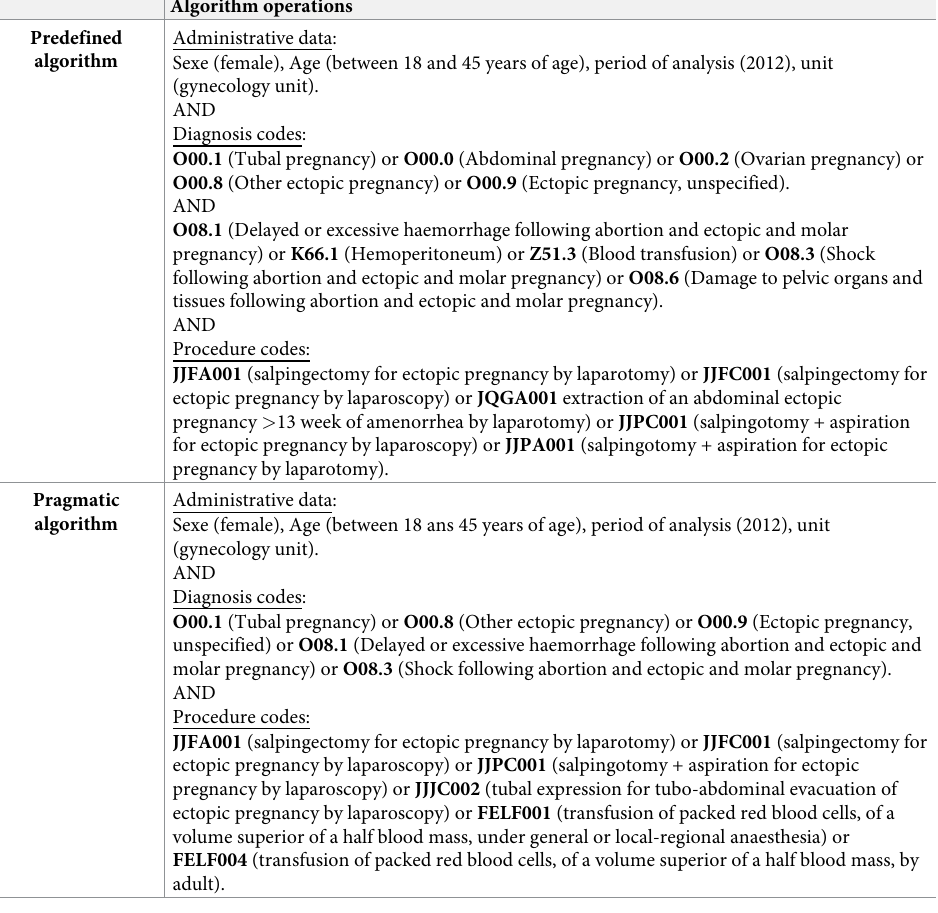
Table 1. Items integrated into the algorithms used to identify hospital stays for complicated ectopic pregnancy with severe bleeding (CEPSB) in the HDD. Algorithm